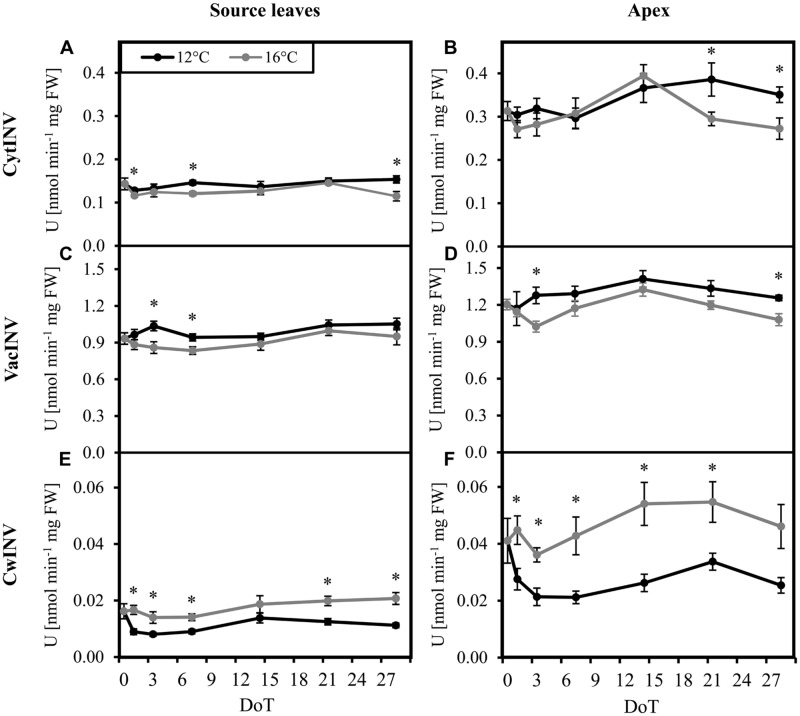
Invertase activities. Impact of sub-optimal temperature (black: 12°C, gray: 16°C) on invertase activities. (A) source leaves, cytoplasmic invertase (cytINV); (B) apex, cytoplasmic invertase; (C) source leaves, vacuolar invertase (vacINV); (D) apex, vacuolar invertase; (E) source leaves, cell wall invertase (cwINV); (F) apex, cell wall invertase. (DoT = days after differentiation of temperature; n = 10; data are means ± SE, asterisks indicate significant differences between temperature treatments for a given sampling time, P ≤ 0.05).